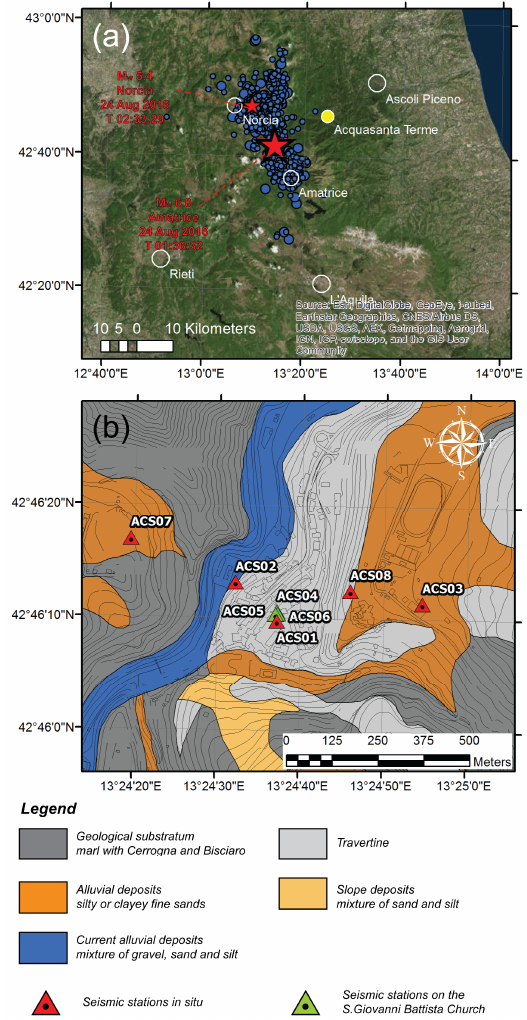
Figure 1 : (a) Epicenters (small circles) of the August 2016 Amatrice seismic sequence. The bigger red star represents the mainshock. (b) Geological map of the near-surface ge- ology of Acquasanta Terme town, the red and green trian- gles represent the installed seismic stations for this